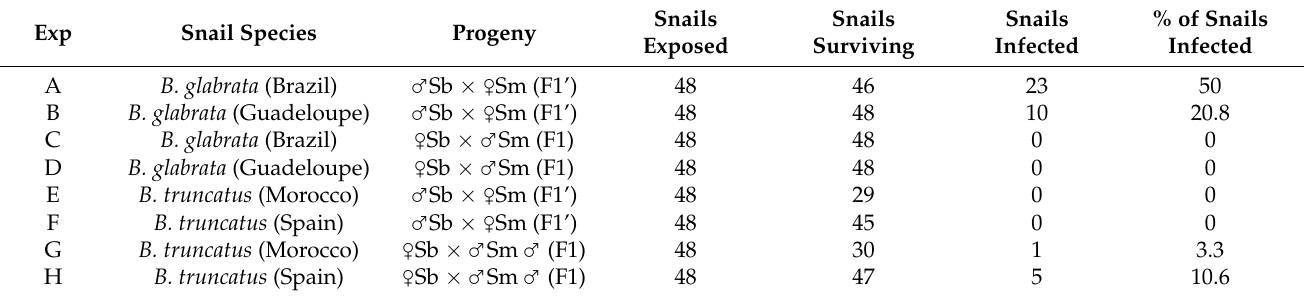
Table 5. Compatibility of F1 progeny of S. bovis (male) × S. mansoni (female) and S. mansoni (male) × S. bovis (female) in Biomphalaria glabrata and Bulinus truncatus . Each snail was exposed to 12 miracidia. Sb: S. bovis , Sm: S. mansoni